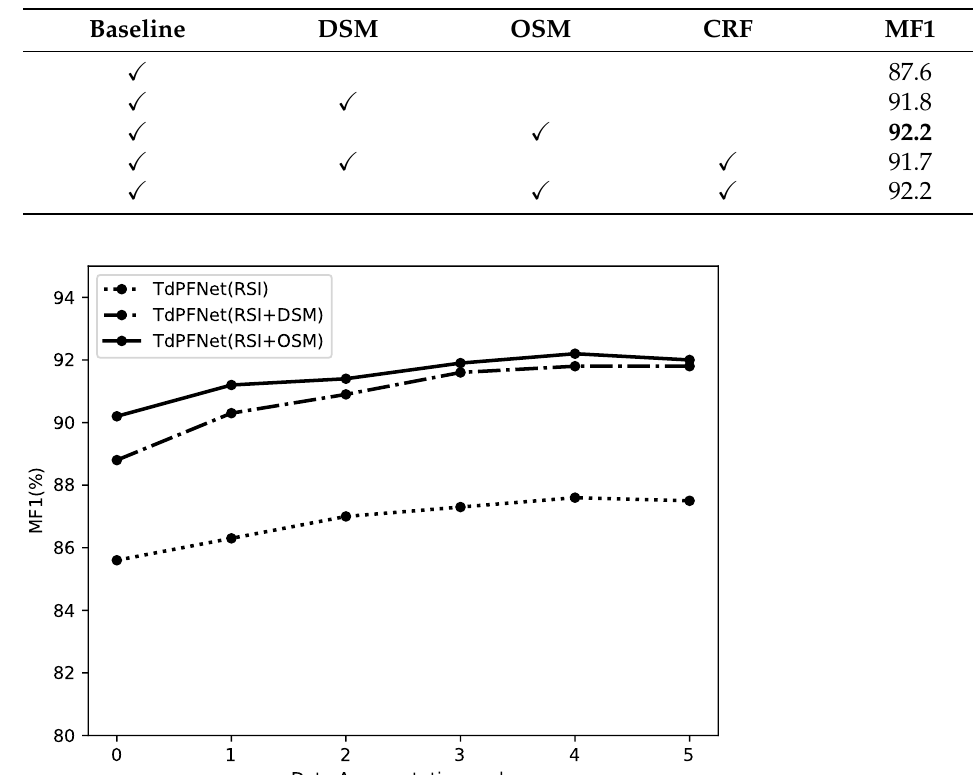
Figure 9. Samples from the prediction results on Potsdam test set. From left to right, they are the data for ( a ) original high-resolution remote sensing RGB images, ( b ) the corresponding ground truth, ( c ) predictions of TdPFNet(RSI), ( d ) results fused with DSM and ( e ) results fused with OSM. Table 1. The ablation study for each part of TdPFNet on Potsdam test set. DSM: digital surface model. OSM: open street map. CRF: conditional random field. The number in bold is the maximum value.